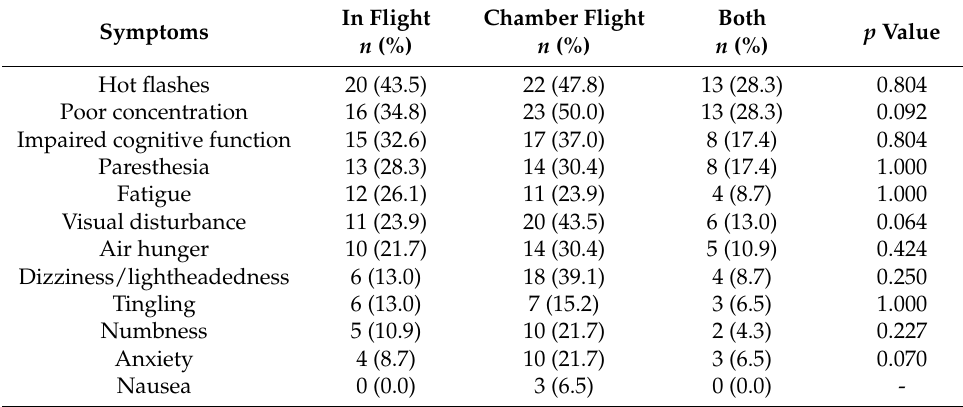
Table 3. Comparison of inflight and chamber-flight hypoxia